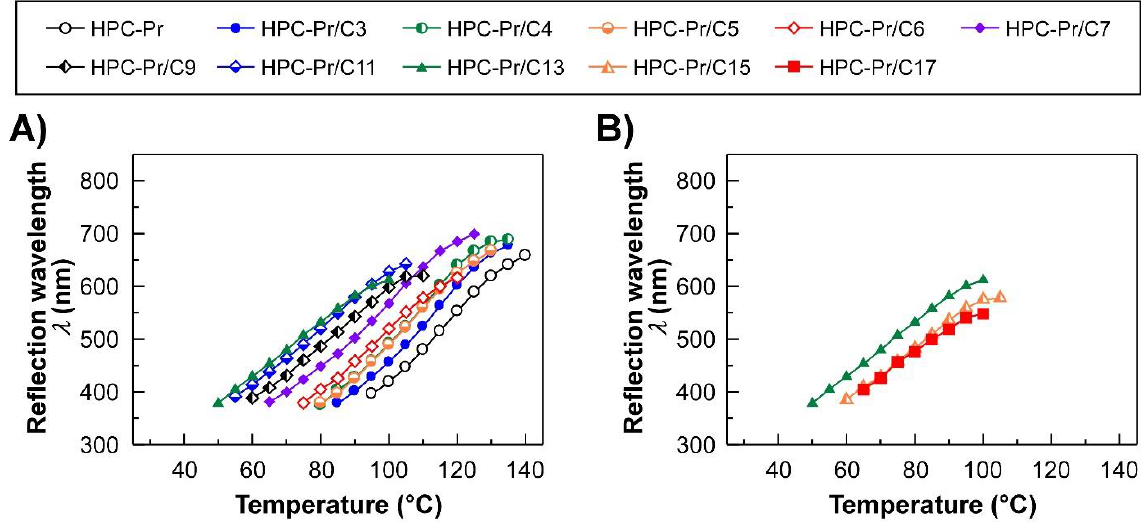
Figure 2. Temperature dependences of reflection peak wavelengths of HPC-Pr/C n . ( A ) HPC-Pr ( n = 2) and HPC-Pr/C n ( n = 3, 4, 5, 6, 7, 9, 11, and 13). The region of temperature at which HPC-Pr/C n reflects visible light shifted toward lower temperatures as n increased. ( B ) HPC-Pr/C n ( n = 13, 15, and 17). The region of temperature at which HPC-Pr/C n reflects visible light shifted toward higher temperatures as n increased.